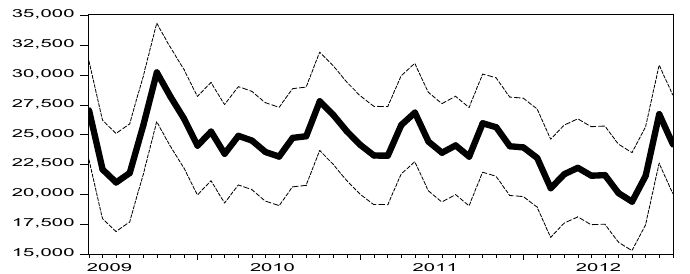
Fig. 6. Construction materials price fluctuation